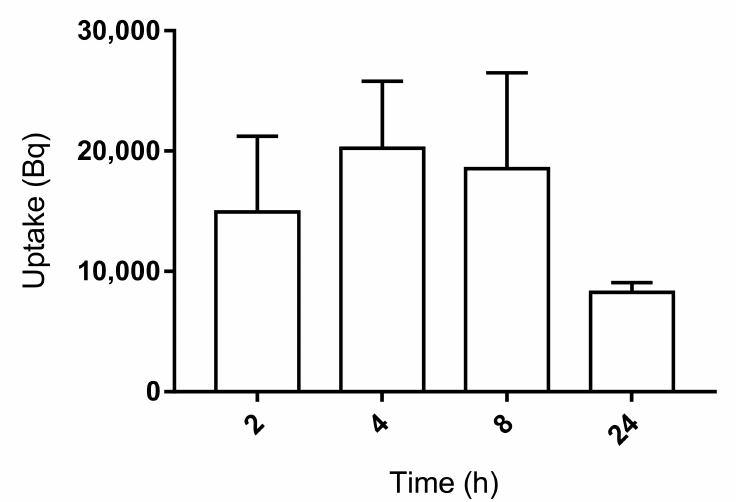
Figure 2. Uptake of [ 111 In]In-IP-001 by A549 cells at different incubation times ( n = 3; mean ±